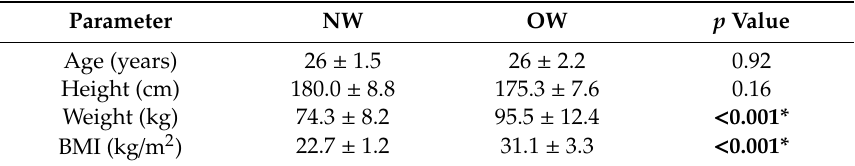
Table 1. Anthropometric data (mean ± standard